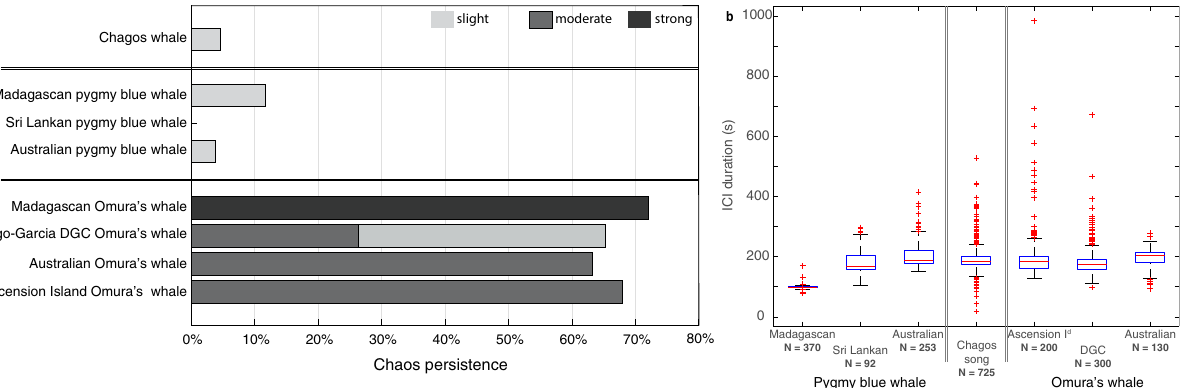
Figure 7. ( a ) Proportion of deterministic chaos ( i.e. , chaos persistence) in the Chagos song compared with the three Indian Ocean pygmy blue whale song types (Madagascan, Sri Lankan and Australian) and the four Omura’s whale song types (Madagascan, Diego-Garcia DGC, Australian and Ascension Island). Chaos persistence is defined as the proportion of deterministic chaos across the entire song duration (given as a percentage). Shades of grey indicate the strength of the chaos: slight (light grey), moderate (medium grey) and strong (dark grey)). ( b ) Boxplot representation of the Inter-call Intervals (ICI expressed in s) for the different song-types measured in this study. On each box, the central mark is the median, the edges of the box are the 25th and 75th percentiles, the whiskers extend to the most extreme data points considered to be not outliers, and the outliers are plotted